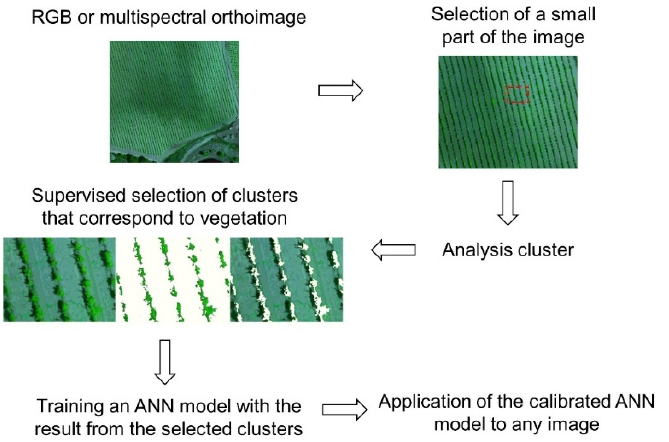
Figure 4. Flowchart of the segmentation of vegetation by LAIC software in a vineyard located in Fuente-Álamo, Spain.